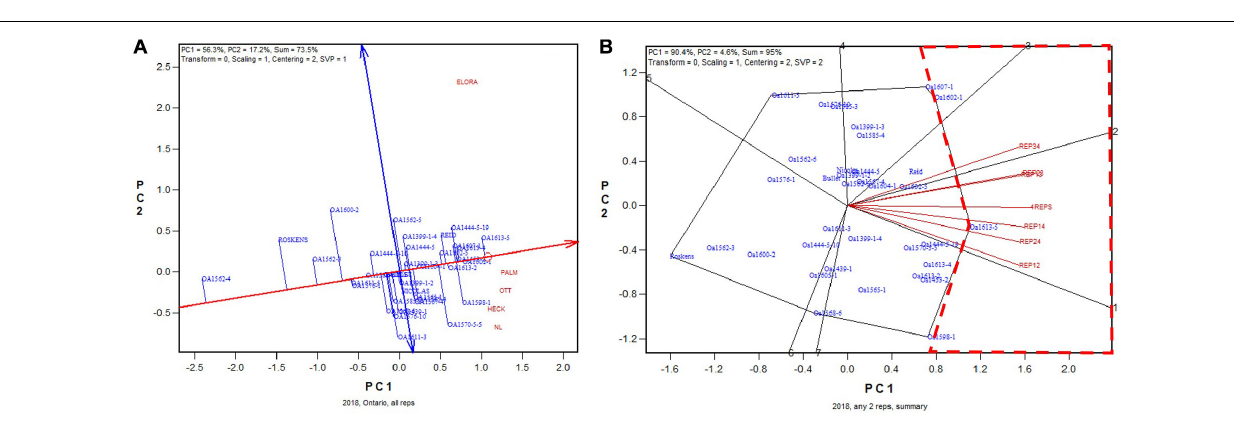
FIGURE 7 | Biplots for the 2018 Ontario trials. (A) GGE biplot to show genotype ranking based on data from all four replicates, and (B) summary biplot to show the genotype rankings based on all four replicates and on any two of them. 4REPS, genotypic ranking based on all four replicates; REP12, genotypic ranking based on replicates 1 and 2; REP13, genotypic ranking based on replicates 1 and 3, and so